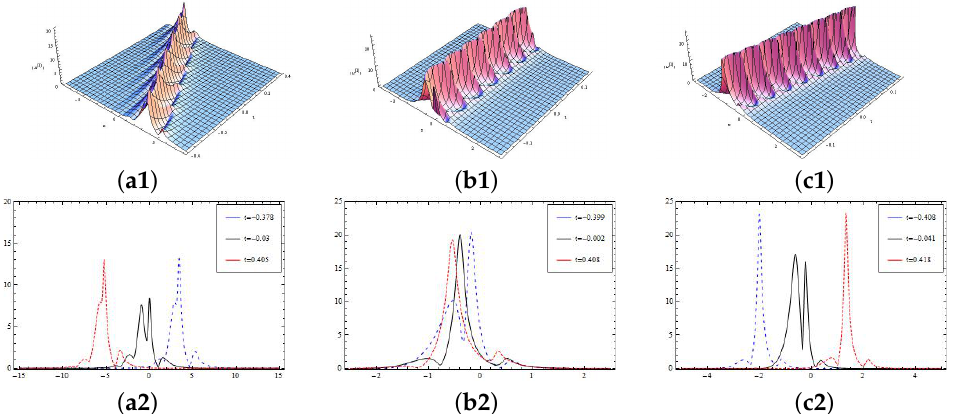
Figure 2. Breather-like solution for the focusing nonlocal gSS equation Equation (5) with (cid:101) = 1,